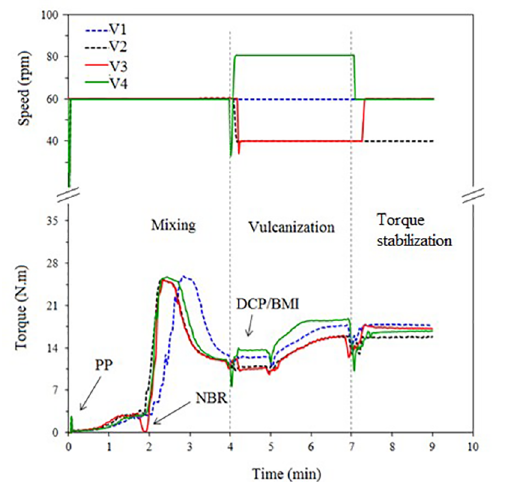
Figure 1. Evolution of actual rotor speed and torque with mixing time as a function of rotor speed profile at dynamic vulcanization of PP/NBR (30/70 phr): V1 (blue dashed line), V2 (black dashed line), V3 (red line) and V4 (green